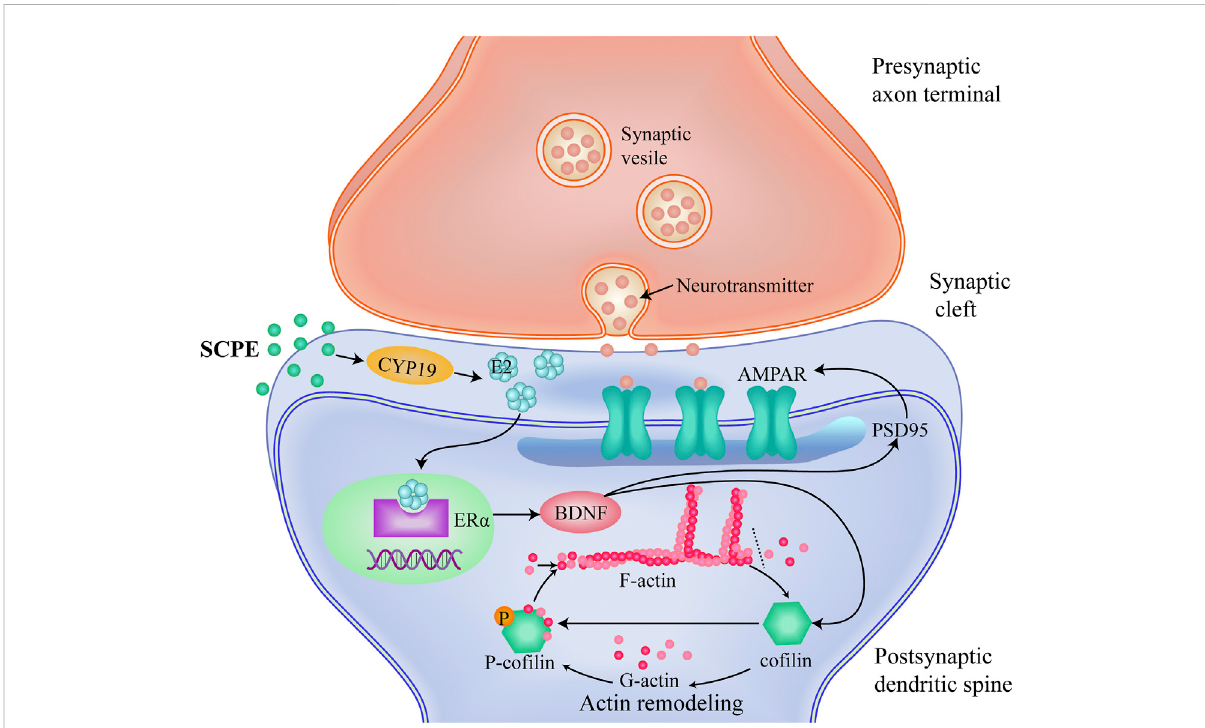
FIGURE 6 AproposedmechanismwhichSCPEcouldbeapotentialtreatmentforAD.SCPEincreasesthelevelsofE2andCYP19,promotesthesynthesisof brain-derived E2 inhippocampal neurons.Andthen SCPEinducesthe increased expression of ER α in thebrain to exert estrogenic effects.Estrogenic effects increase the release of brain-derived BDNF and alter the function and structure of excitatory synapses.Furthermore, SCPE interacts with multiple proteins at synapses. It phosphorylates co fi lin to stabilize actin fi laments and promotes actin polymerization. Actin polymerization resultsindendriticspineenlargement,andlateralmovementofAMPARsintothesynapse.Theseinteractionsintegrateupstreamsignalsintodynamic changes in the actin cytoskeleton that work to regulate synaptic plasticity. SCPE fi nally improves synaptic plasticity by increasing the effect of estrogen to achieve the purpose of treating